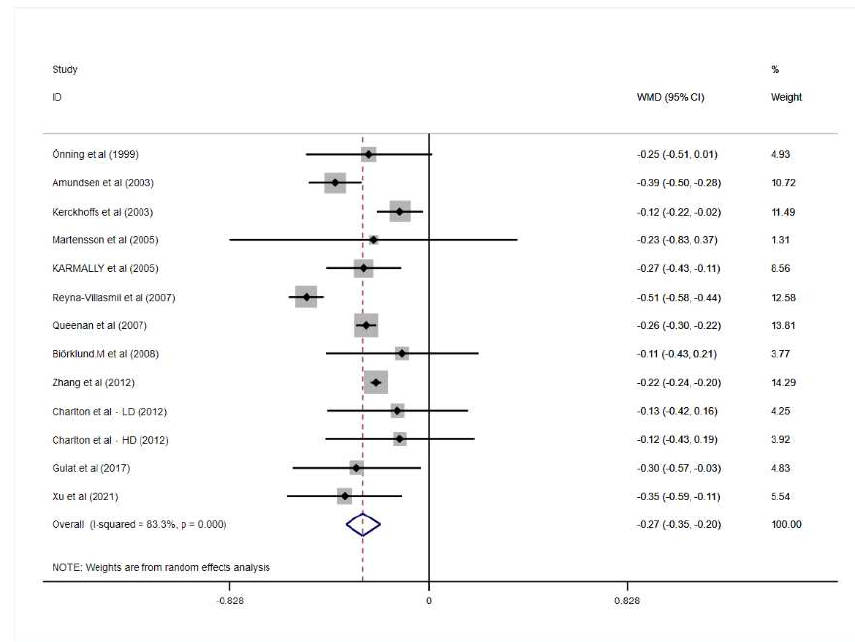
Figure 5. Effect of oat β-glucan on low-density lipoprotein-cholesterol (mmol/L) in patients with hyperlipidemia. Open diamonds: synthesis of summary results of all studies; Filled diamonds: point estimates for effect of each study; Dashed lines: summary effect estimate which is labeled as a dashed line perpendicular to the X axis; Grey squares: the weight of each study, the value of weigh is proportional to the diamond size; WMD: weighted mean difference.